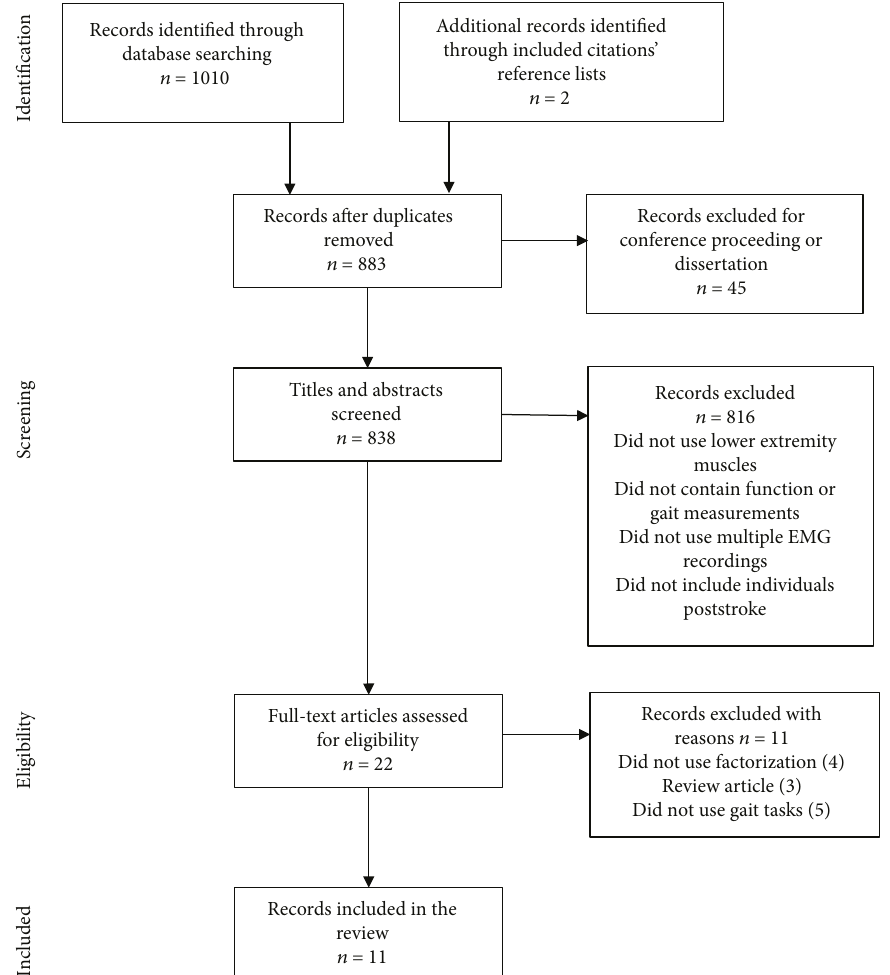
Figure 2: Search